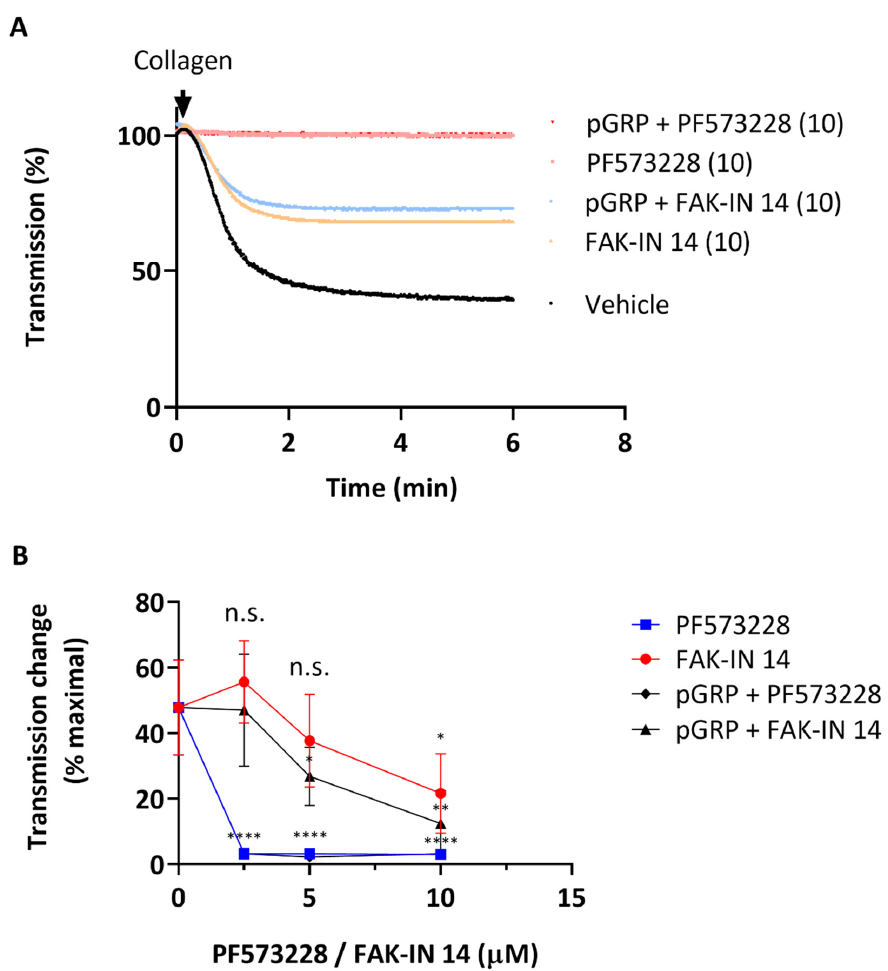
Figure 2. Effects of GPR56 and PTK2 interference on collagen-induced platelet aggregation. Washed platelets (250 × 10 9 /L) were incubated with vehicle (control), pGRP peptide (50 µ g/mL), and indicated PTK2 inhibitor (2.5–10 µ M) for 10 min. Platelet aggregation was monitored by light transmission in response to collagen I (1 µ g/mL). ( A ) Representative traces of collagen-induced aggregation. ( B ) Dose-dependent effect of PTK2 inhibitors on maximal aggregation. Mean values ± SD (n = 3 donors); n.s., not significant, * p < 0.05, ** p < 0.005, **** p < 0.0001 vs. vehicle (paired Student’s t -test).